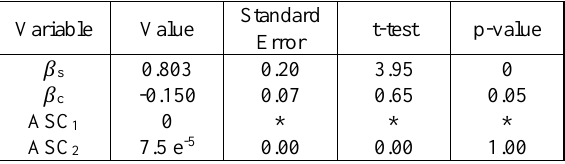
Table 6. DCM Results for scenario 2